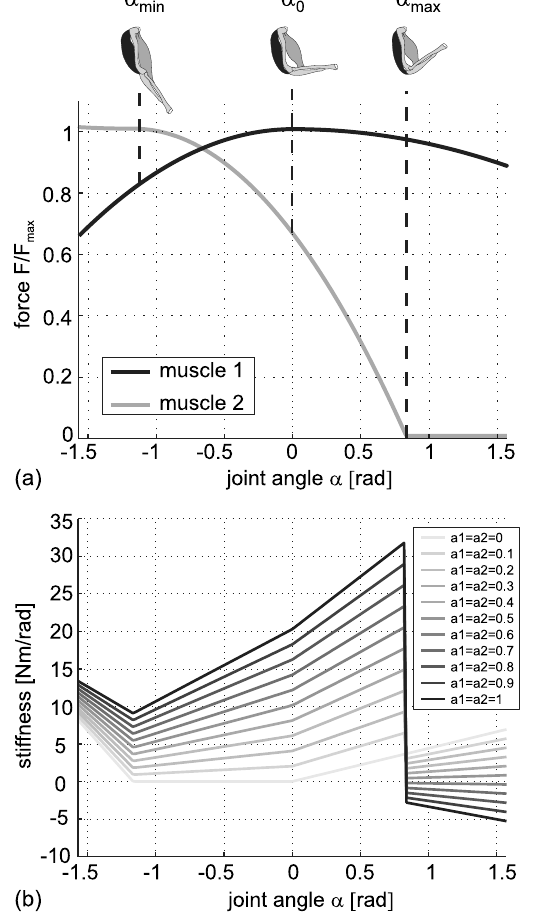
Fig. 2. (a) Forces in a hinge joint generated by two antagonistic muscles plotted over joint angle for maximal activation. The dashed lines indicate force contributions corresponding to three different joint positions. (b) Joint stiffness plotted over joint angle for the setupintroducedin(a)forperfectco-activation( a 1 = a 2 ).Maximum co-activation is depicted in